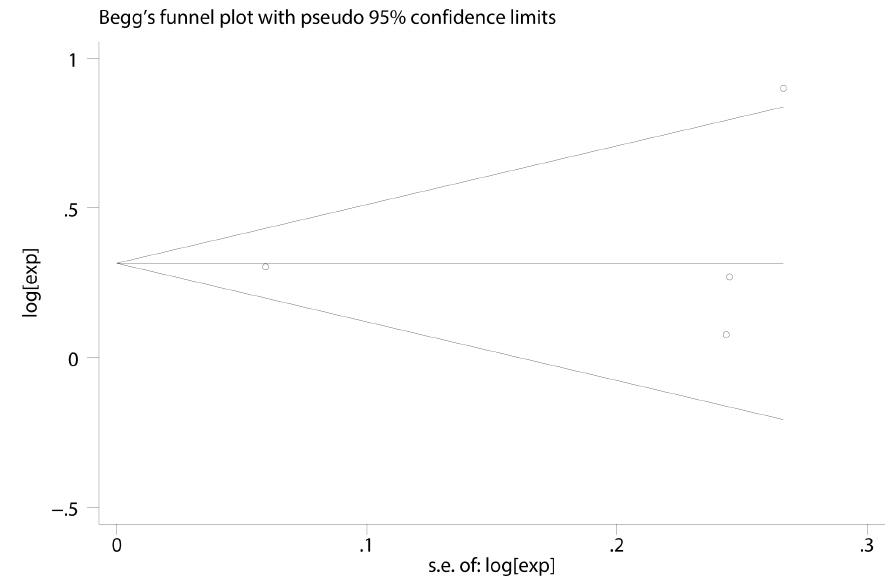
Figure 9. Begg’s test result of DFS.